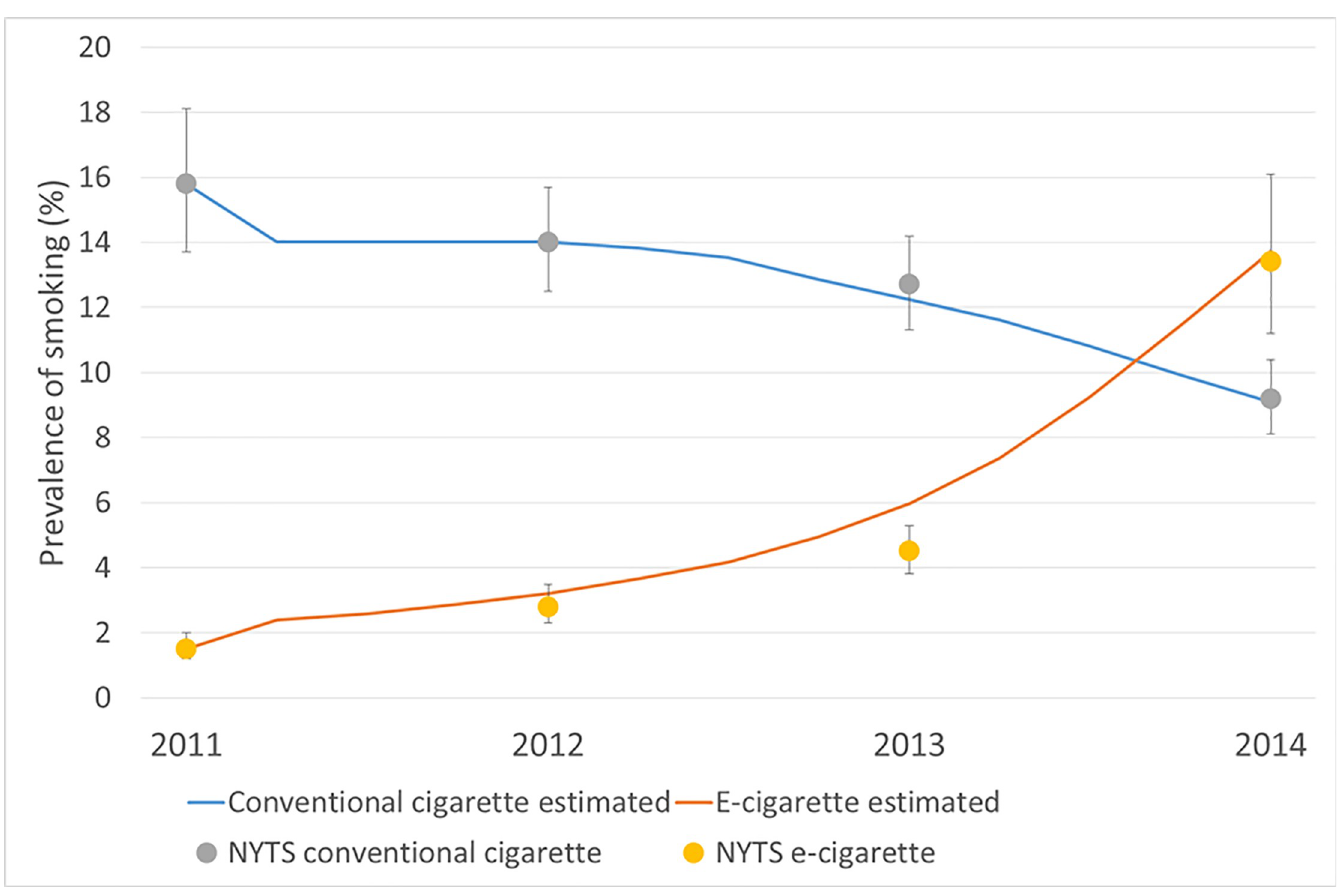
Fig 2. Simulated prevalence rates by type of smoking (lined) compared with the actual trends (dot) among teenagers in high school in the United States, 2011– 2014. For each included year, United States National Youth Tobacco Survey data were referred to for the actual prevalence rates and their 95% confidence